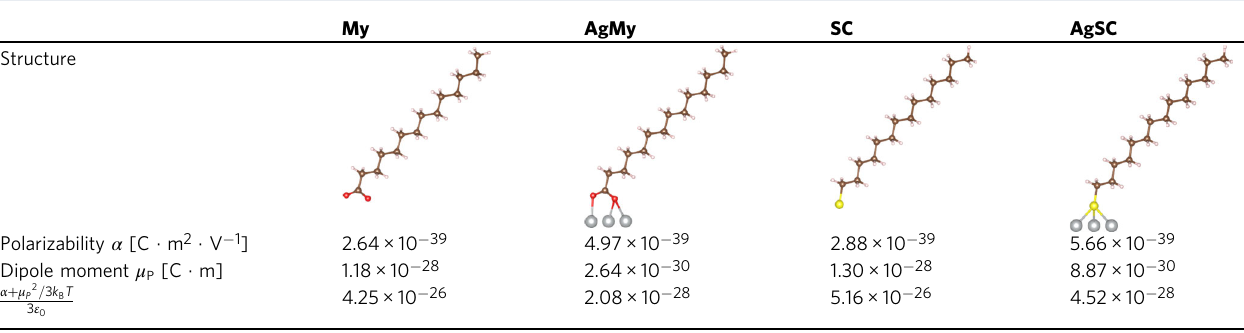
My AgMy SC AgSC